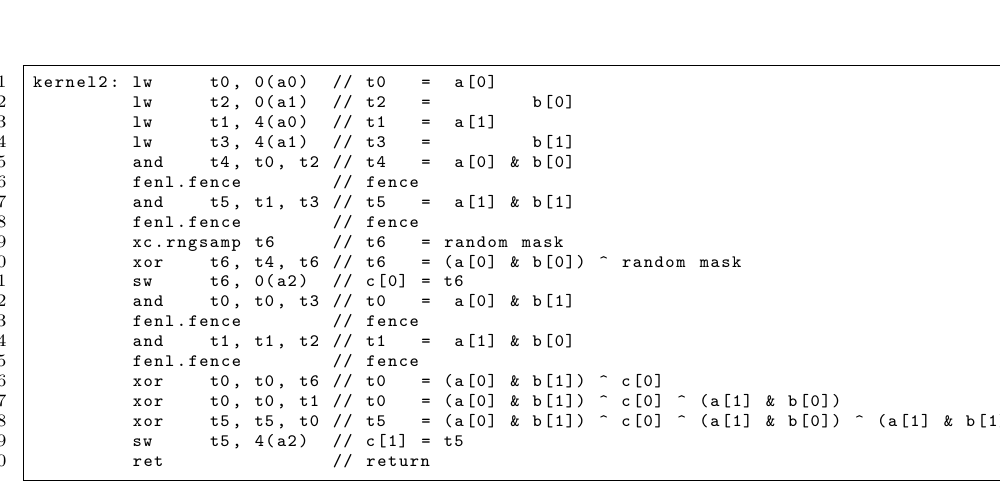
Figure 6: Target kernel for experiment 2: 2-share ISW [ISW03] multiplication. Note that the kernel is described post -insertion of fence instructions; the original, pre -insertion version can be inferred by ignoring said instructions (i.e., lines 6, 8, 13, and 15). This kernel is based on the implementation of Goudarzi et al. [GJRS18], adapted for RISC-V from ARMv7.